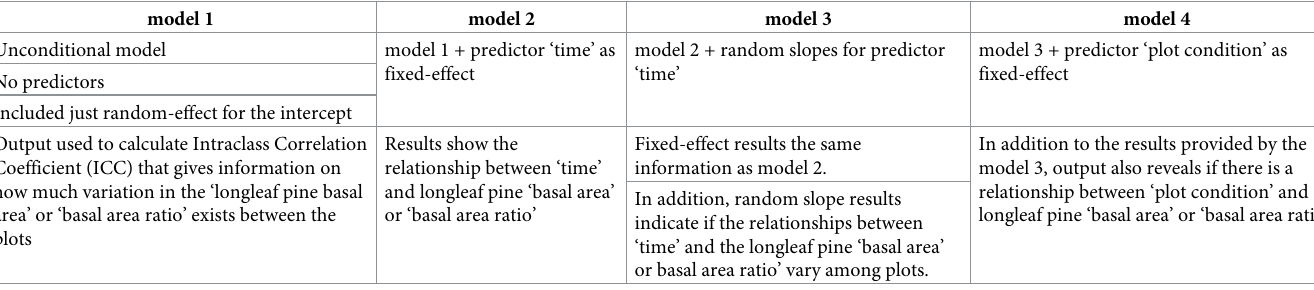
Table 2. Linear models building